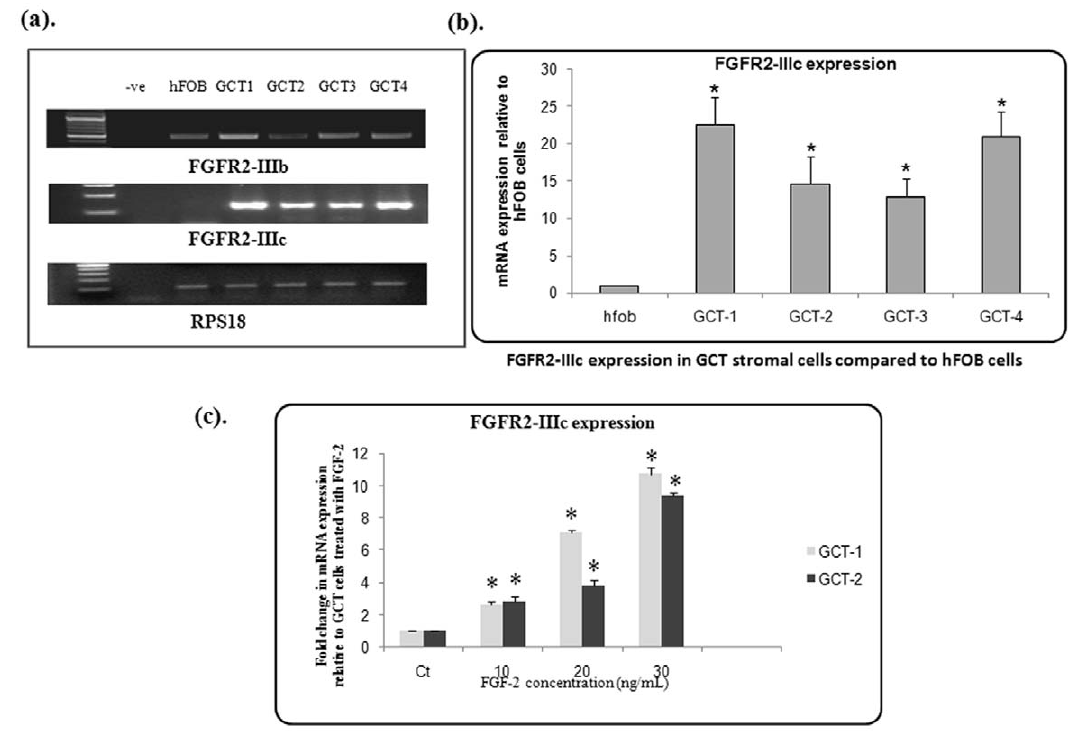
Figure 1. Semi-quantitative PCR. ( a ). Endogenous expression of FGFR2-IIIb and FGFR-2IIIc in GCT stromal cells using FGFR2 specific primers. ( b ). Real-time PCR of cDNA from GCT stromal cell lysates showing expression of FGFR2-IIIc relative to hFOB 1.19 cells (‘‘hFOB’’). Results are the average of three replicate experiments. ( c ). An increase in expression of FGFR-2IIIc is in response to FGF-2 ligand in GCT stromal cell in a dose dependent manner. Results are the average of three replicate